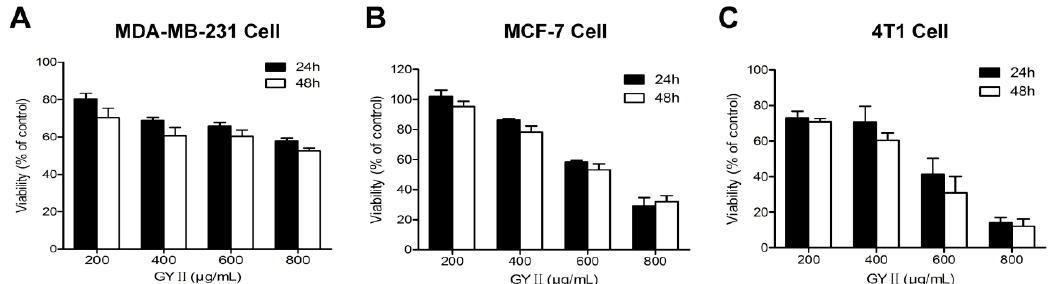
Figure 3. Dose-dependent inhibitory effect of GYII on breast tumor cell proliferation. Three breast tumor cell lines were treated with GYII at different concentrations and cell survival was monitored using the 3-(4,5-dimethyl-thiazol-2-yl)-2,5-Diphenyl tetrazolium bromide (MTT) assay. Absorbance (570 nm) was measured as an indicator of cell survival, and the control group viability was defined as 100%. Proliferation of 4T1 ( C ) and MCF-7 ( B ) cells was dose-dependently inhibited by GYII , while proliferation of MDA-MB-231 cells ( A ) was moderately affected.